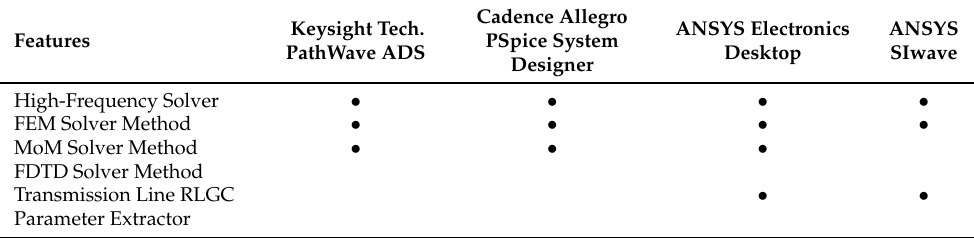
Table 2. Comparison of the main features software for 2.5D electromagnetic